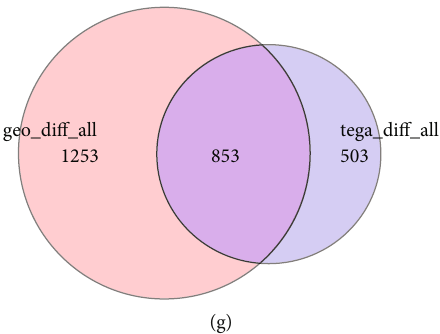
Figure 1: DEGs screening. DEGs of cancer patients and healthy group are screened from GEO database using (a) edgeR and (b) limma. DEGs of cancer patients and normal groups are screened from TCGA database using (c) edgeR and (d) limma. Overlapped DEGs of all (e), upregulated (f), and downregulated (g) are obtained from GEO and TCGA